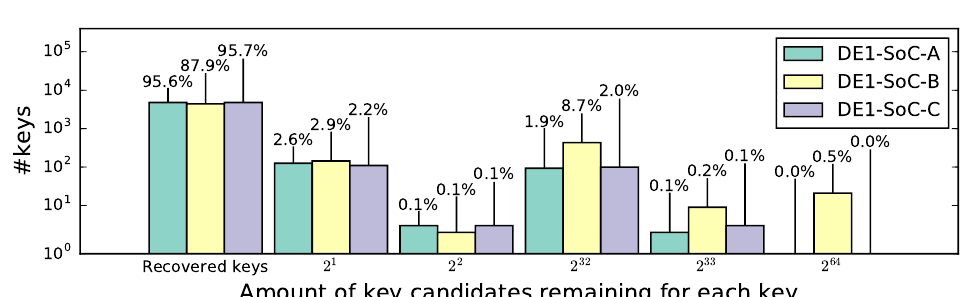
Figure 12: Amount of key candidates remaining for each DFA key recovery attempt on 5000 randomly drawn AES keys on three different DE1-SoC boards ciphertext pairs per